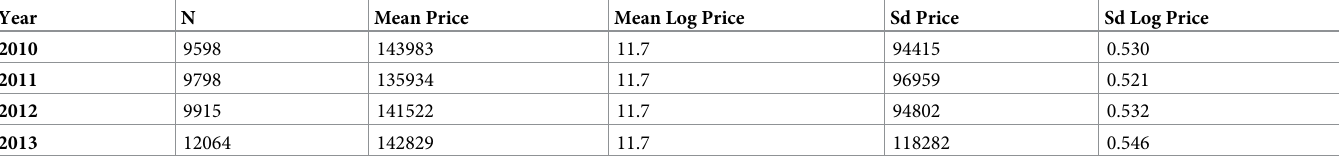
Table 1. Summary statistics for South Yorkshire only. All prices are in